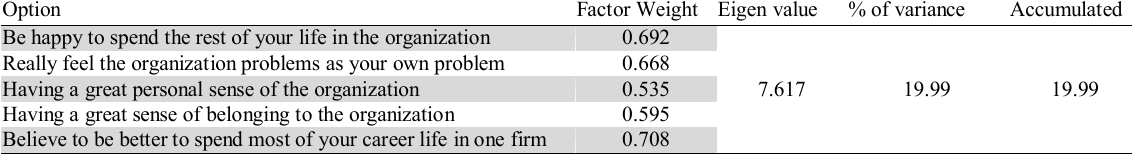
Details of factor analysis for affective commitment surrounding Organizational commitment Option Factor Weight Eigen